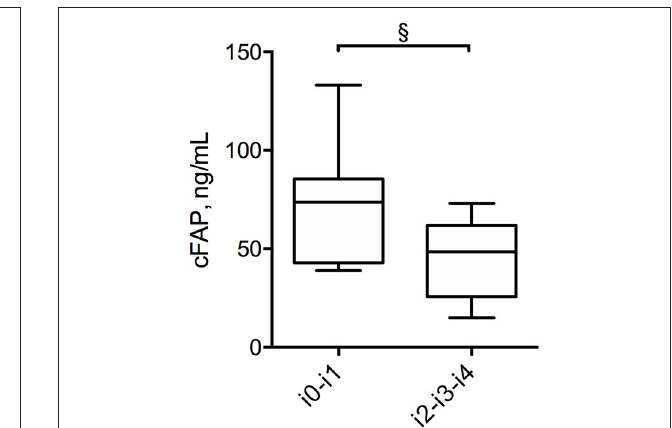
FIGURE 3 | Box plot displaying the concentration of cFAP in patients with CD at pre-operative stage (t0) and at 12 months post-surgery (t12). Statistical analysis was performed by paired Wilcoxon test, # p = 0.02.